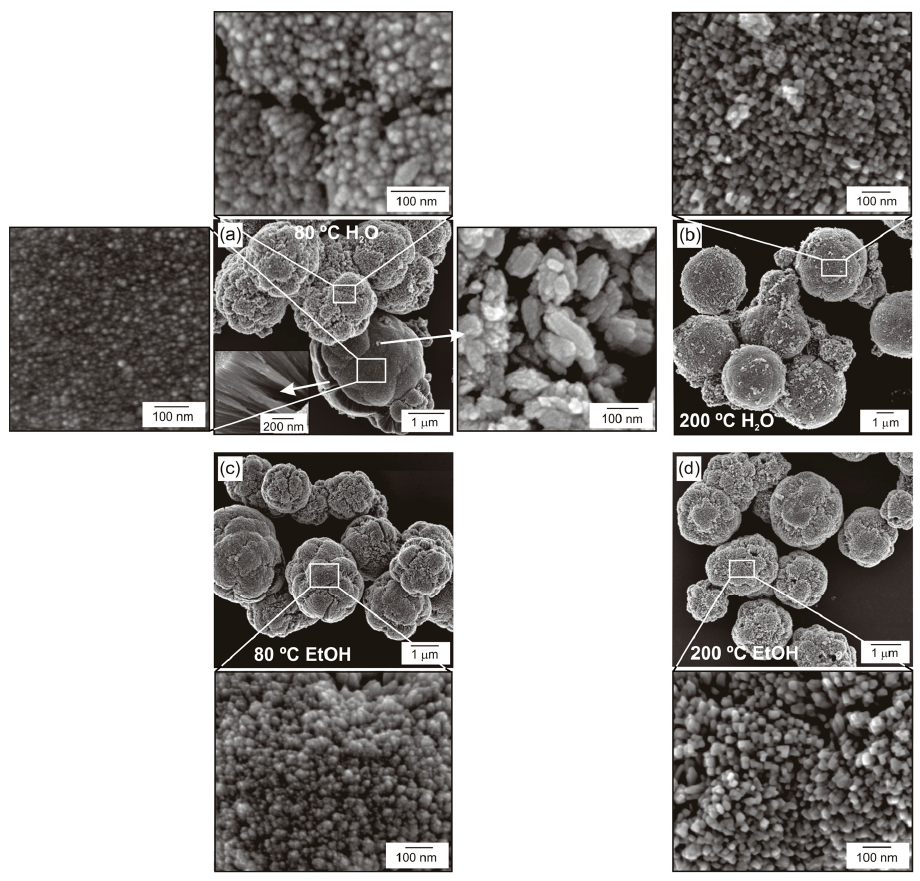
Figure 3. SEM images showing the TiO 2 nanorod spheres produced under microwave irradiation with water as solvent at: ( a ) 80 ◦ C; and ( b ) 200 ◦ C; and using ethanol at: ( c ) 80 ◦ C; and ( d ) 200 ◦ C. The insets magnify the nanorod structures, and the arrows in ( a ) point to the nanorod structure inside the sphere ( left side) and to the distinct TiO 2 structure observed on the powder synthesized at 80 ◦ C ( right side) and using water as solvent.